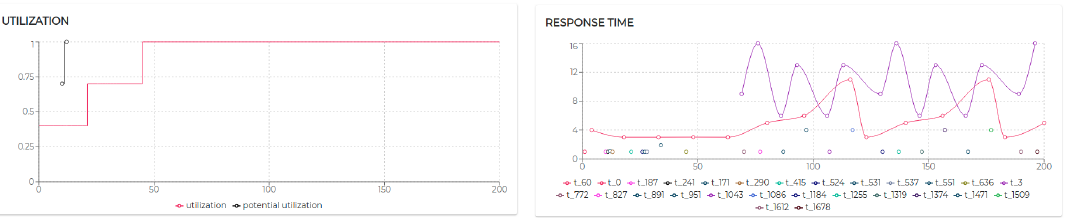
( a ) Utilization over 200s of the agent 5 in S3rt; y-axis: utilization (adimensional); x-axis: time (seconds). Figure 17. Utilization and response time of agent 5 in